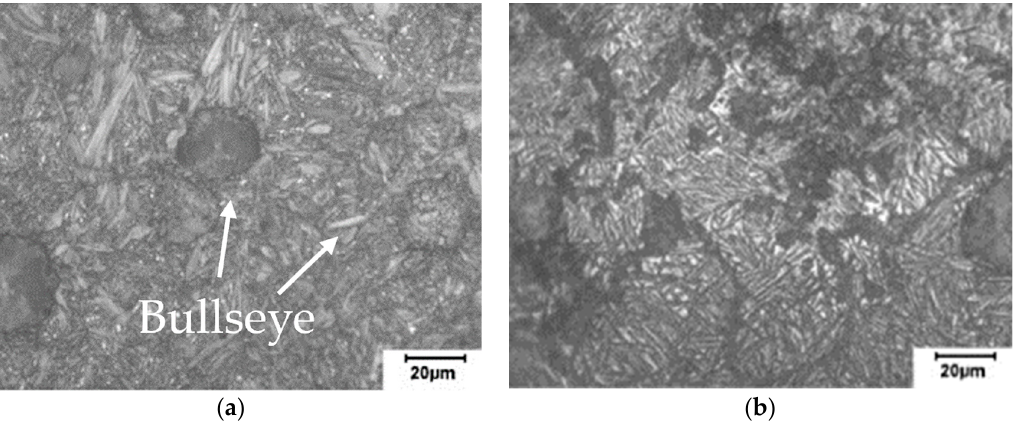
Figure 10. Micrographs of ( a ) top and ( b ) medium zones of the laser hardened ADI sample (Reprinted with permission from ref. [60]. 2011